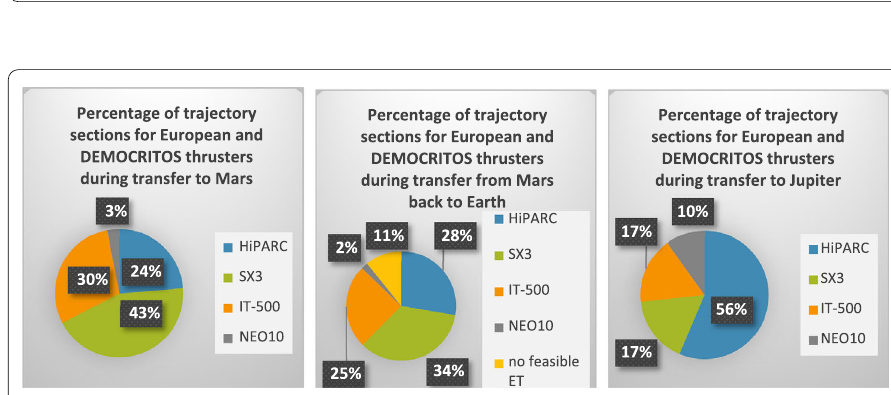
Figure 8 CAD design of gridded cluster plate including European/DEMOCRITOS electric thrusters with redundant PPUs for each thruster at the backside. Thruster colours show the colour of the plume, due to the preferred propulsion